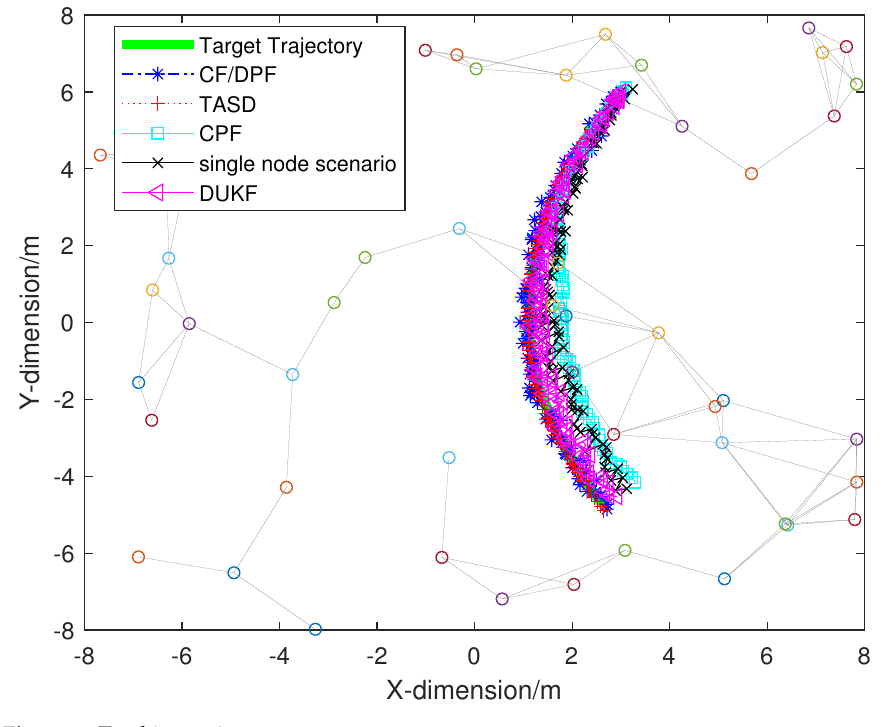
Figure 4. Tracking